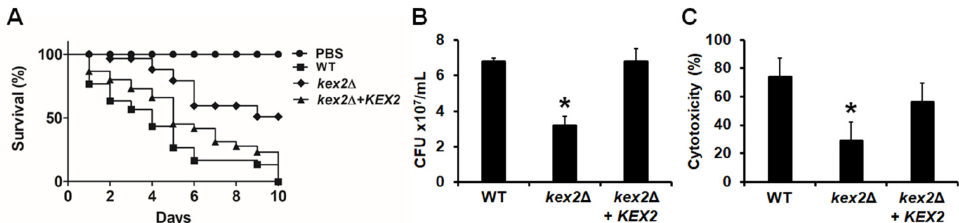
Figure 6. The Candida albicans kex2 Δ null mutant strain display defects in the interaction with larvae of Galleria mellonella . In ( A ), groups of 30 larvae of G. mellonella were injected with cells from the three strains under study and the survival was monitored daily for ten days. As a control, one animal group was inoculated with the vehicle for cell dilution (PBS). In ( B ), the hemolymph was recovered from both life and killed animals, aliquots were plated on Sabouraud plates, incubated at 28 °C for 48 h, and the colony-forming units (CFU) determined. In ( C ), groups of 20 animals were inoculated with 2 × 10 7 cells from the strains under analysis, incubated for 24 h at 28 °C, and then the animals were decapitated, 10 μ L of hemolymph recovered per animal and used to quantify the amount of released lactate dehydrogenase. For ( B ) and ( C ), results are means ± SD. * P < 0.05, when compared with WT or reintegrant control cells. Strains used are NGY152 (WT), HMY209 ( kex2 Δ ), and HMY210 ( kex2 Δ + KEX2 ).